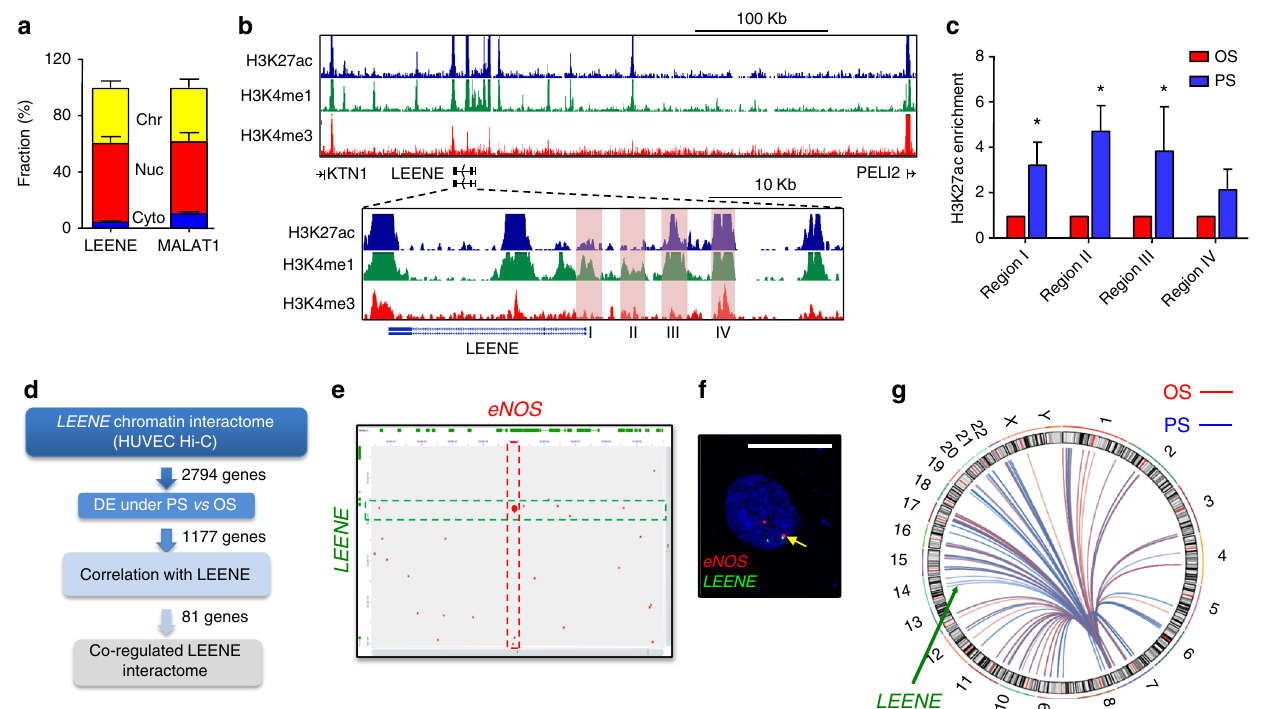
Fig. 3 LEENE RNA is nucleus-localized and its DNA lies in enhancer region interacting with eNOS promoter. a qPCR quantitation of LEENE and MALAT1 in subcellular fractions from ECs, plotted as percentages in association with chromatin (Chr), nucleoplasm (Nuc), and cytoplasm (Cyt). b ENCODE HUVEC ChIP-seq signals in 400 kb (top tracks) and 50 kb (bottom tracks) regions surrounding LEENE . Regions in shades were selected for H3K27ac ChIP-qPCR in c . d Flow chart of integrative Hi-C and RNA-seq analyses. e LEENE – eNOS interaction map generated from GEO HUVEC Hi-C analysis. Red pixels represent interactions between two regions, respectively, in chr7 ( X -axis) and chr14 ( Y -axis). The highlighted regions correspond to eNOS promoter and LEENE enhancer regions. f Representative image of DNA FISH with respective probes recognizing LEENE and eNOS genomic loci. Arrow indicates proximity association between two loci. Scale bar = 10 μ m. g 4C-seq mapping of inter-chromosomal interactions between eNOS bait (249 bp) and lncRNAs listed in Fig. 1b. Each line in the circoplot represents an interaction and the color intensity re fl ects the normalized reads of ligated DNA ends. Chromosomes are numbered around the circle. Data are presented as mean ± SEM, n = 5 in each group. * p < 0.05 compared to OS based on Student ’ s t